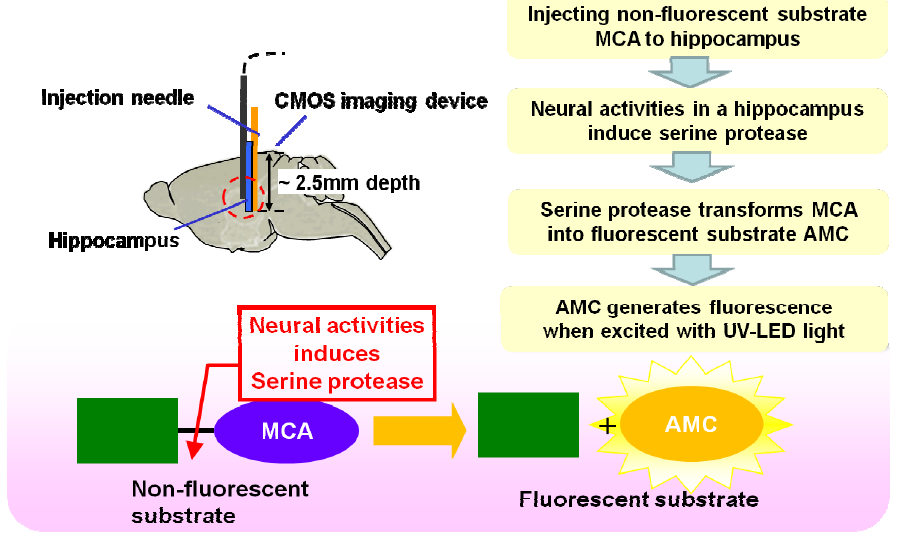
Figure 17. Measurement method of detecting neural activity thorough fluorescence.